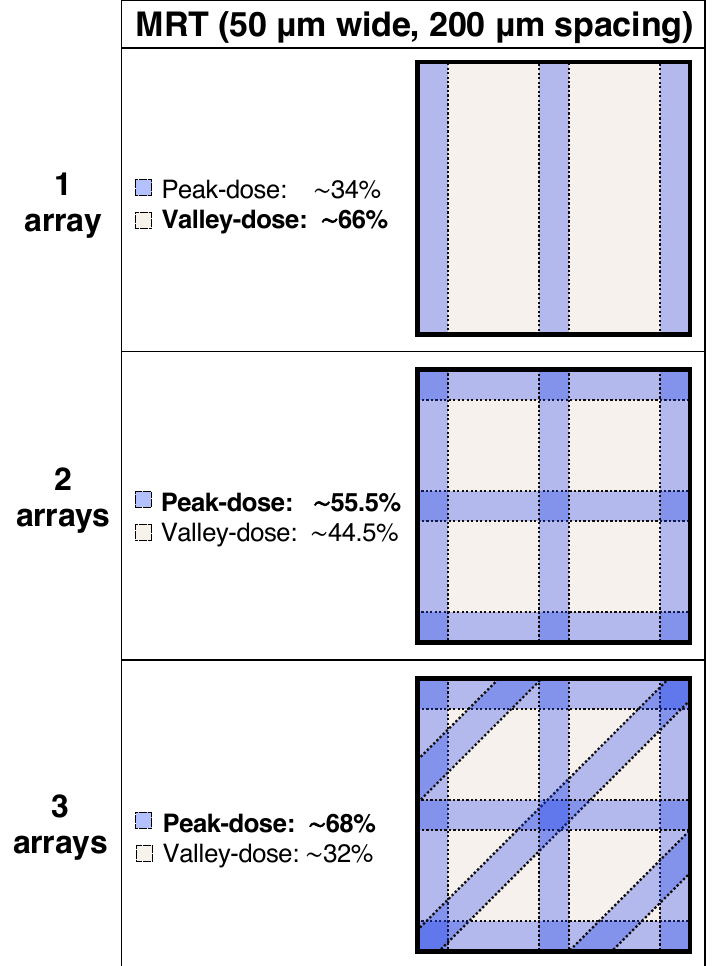
Figure 5. Intersecting the MRT arrays changes the total percentage of tissue exposed to peak and valley doses. This figure is a two-dimensional schematic representation of the geometrical distribution of three intersecting MRT arrays (microbeams 50 µ m in width, 200 µ m spacing) in a squared piece of tissue. As the number of intersecting arrays increases from one to three, the percentage of tissue exposed to peak doses increases in an inversely proportional matter to the percentage of tissue that remains exposed to valley doses.